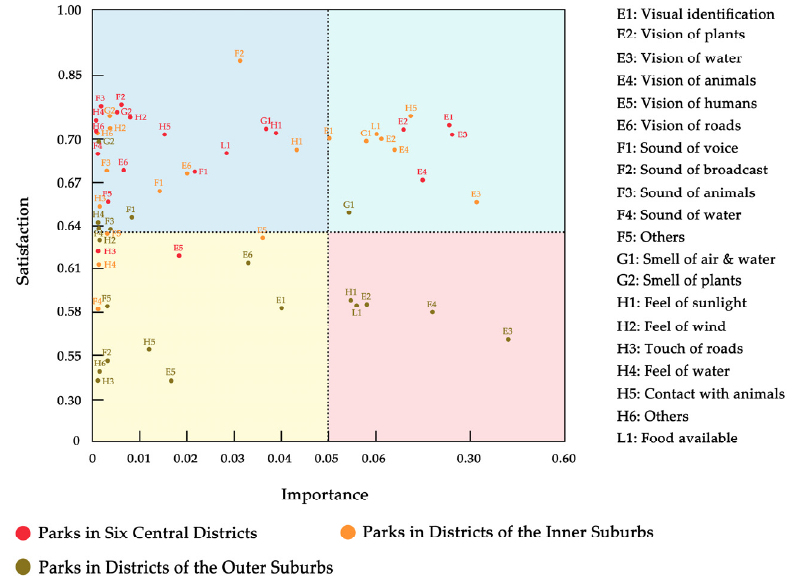
Figure 13. IPA model of riverside parks in different districts based on sensory perception.